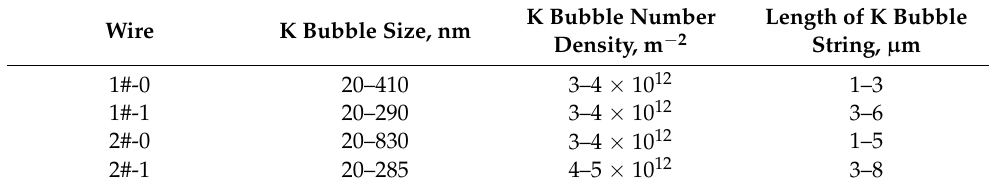
Table 3. K tube and bubble of Φ 0.39 mm tungsten wires at the stage of